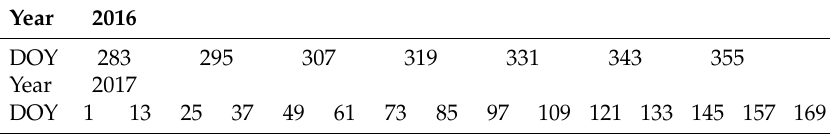
Table 2. Sentinel-1A acquisition dates (the day of year, DOY) u sed in this study.